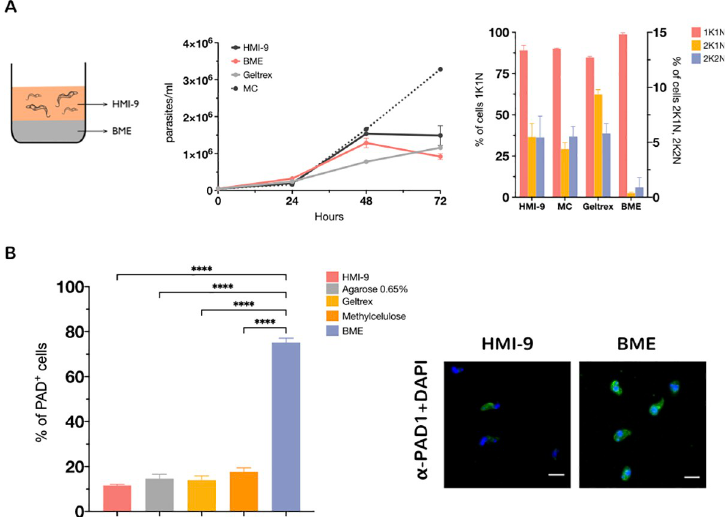
Fig 1. (A) Growth of pleomorphic T . brucei AnTat1.1 90:13 in the presence of different support media. MC: methylcellulose; BME or HMI-9 as a control. n = 2 per group. The right-hand panel shows the proportion of cells with 1 kinetoplast and 1 nucleus (1K1N, G1 and S phase cells), 2 kinetoplasts and 1 nucleus (2K1N, G2 phase cells) or 2 kinetoplasts and 2 nuclei (2K2N, post mitotic cells) from an analysis of 250 cells per condition at 72hs. (B) Expression of the stumpy marker PAD1 in the presence of different support media. ( ���� P < 0.0001, one-way analysis of variance with Tukey’s multiple comparisons test). The right-hand panel shows representative images of PAD1 (green) expressing cells at different BME concentrations. > 400 cells were counted for each condition. The parasite nucleus and kinetoplast (stained with DAPI) is pseudocoloured in blue. Scale bars, 10 μ m. in a 2K1N and 5.4% ± 1.9 in a 2K2N configuration. These results show that including BME in